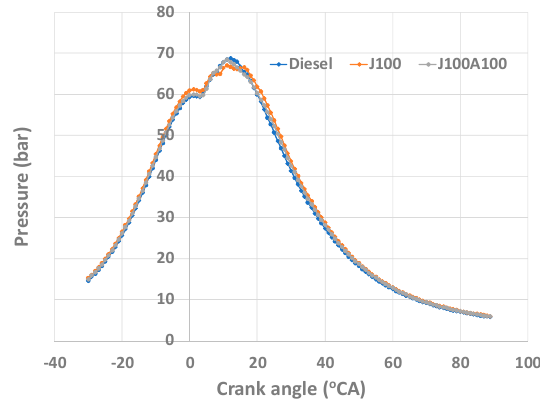
Energies 2019 , 12 , x FOR PEER REVIEW Figure 12. Cylinder pressure at 100% Load. Figure 12. Cylinder pressure at 100% Load. Figure 12. Cylinder pressure at 100% Load.